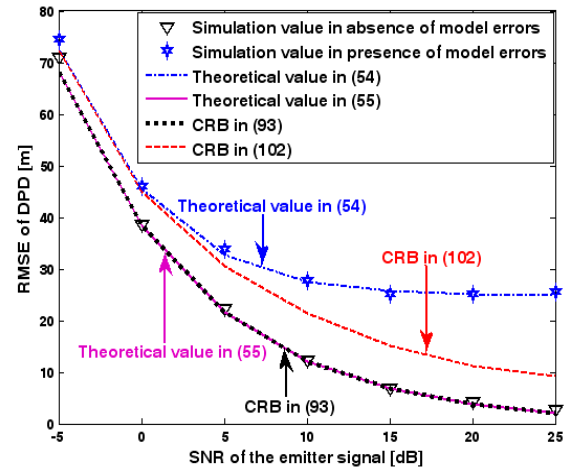
Figure 2. Root-mean-square-error (RMSE) of direct position determination (DPD) versus signal-to-noise ratio (SNR) of the emitter signal.